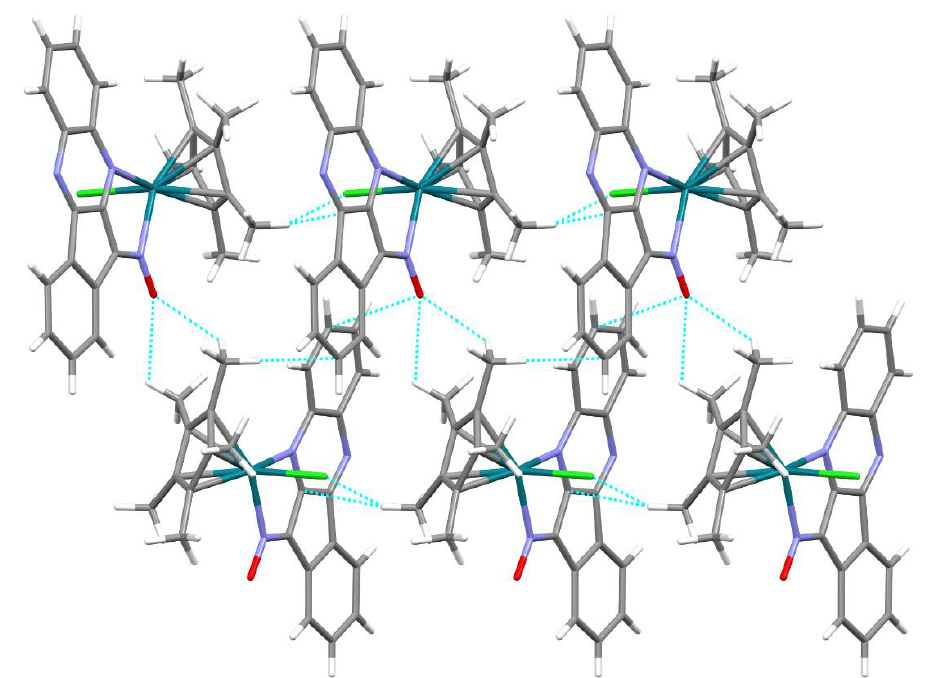
Figure 5. A packing diagram of compound 2 showing a homochiral supramolecular structure (view along axis c ). Short contacts are shown as dashed lines.